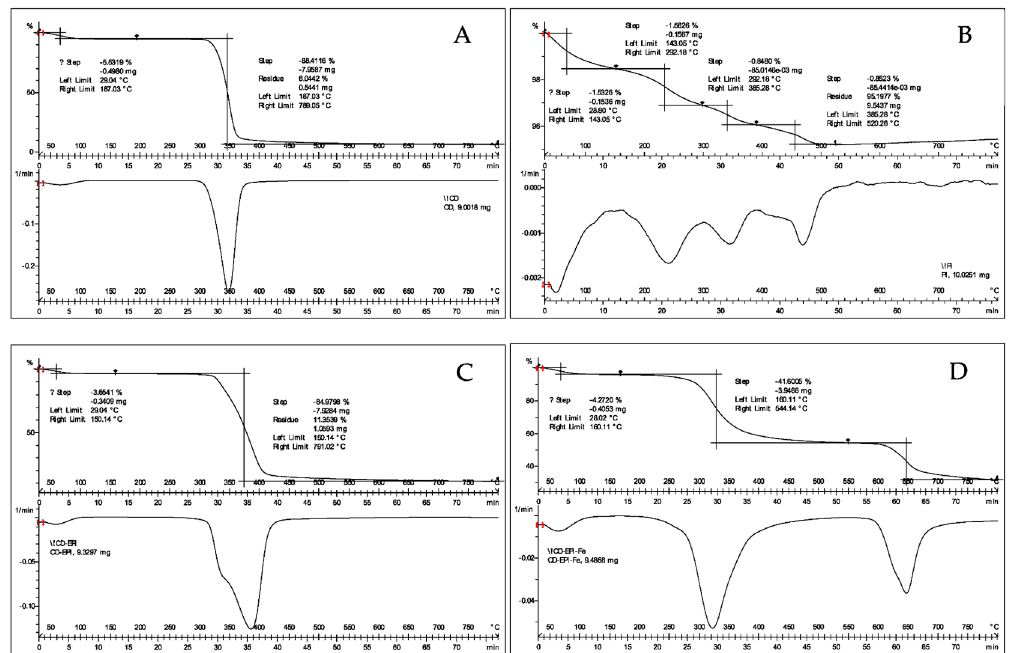
Figure 3. The differential thermal analysis (DTA) curves for the ( A ) β -cyclodextrin, ( B ) Fe 3 O 4 nanoparticles, ( C ) β -cyclodextrin-epichlorohydrin polymer, and ( D ) β -CD-EPI polymer-modified Fe 3 O 4 nanoparticles.